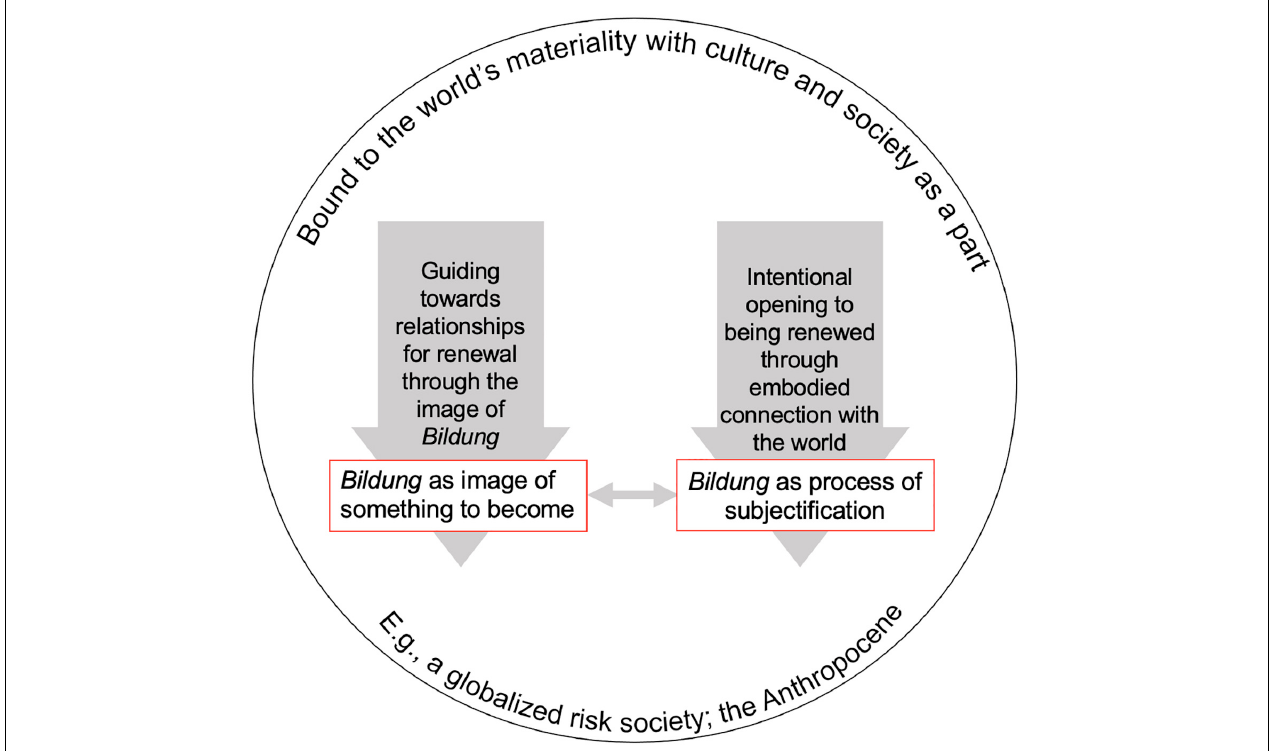
FIGURE 1 | Simplified model of a posthuman understanding of Bildung (Clucas et al. in